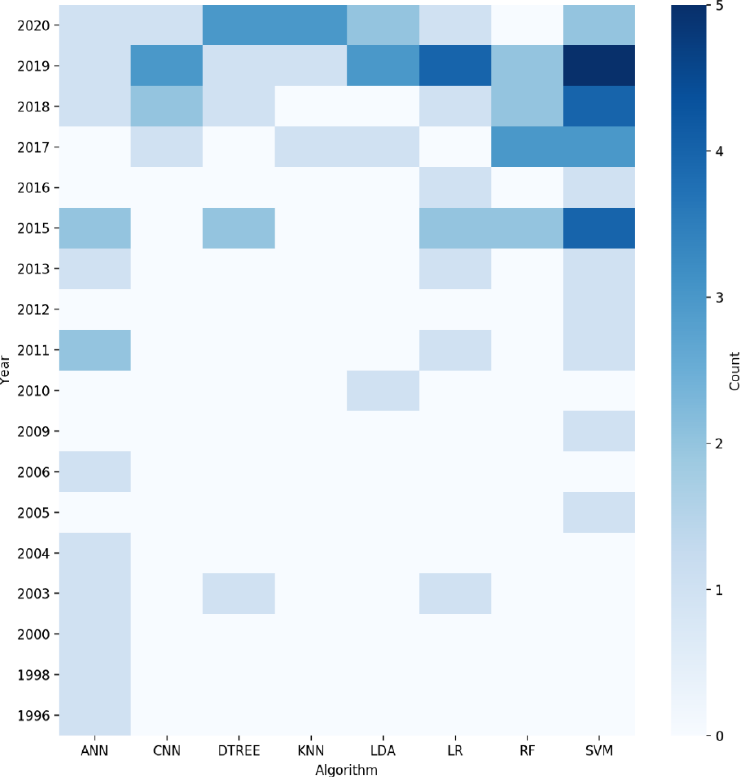
Figure 3. Distribution of publications per year according to different algorithms employed. In this graphic are plotted those algorithms that are most usually used.